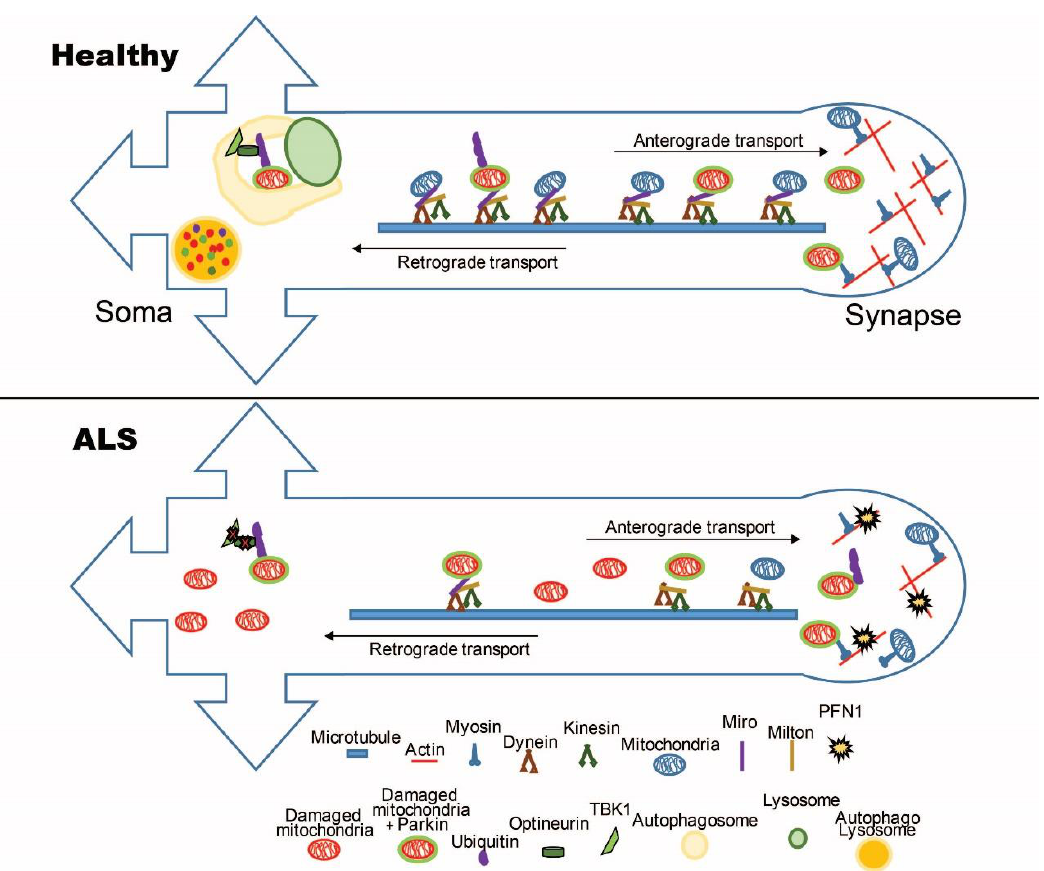
Figure 1. Schematic representation of key players in mitochondrial transport and turnover in healthy and amyotrophic lateral sclerosis (ALS) neurons. Mitochondria are transported in axons along microtubule tracks by dynein and kinesins, which are connected to mitochondria through cargo adaptors Milton and Miro. In ALS axons, the interactions between mitochondria and microtubules are disrupted, resulting in impaired transport. At synapses, mitochondria interact with the actin cytoskeleton, and mutations in proteins involved in actin dynamics, such as PFN1, can alter mitochondrial localization at this neuronal site. Ubiquitination of unhealthy mitochondria by Ub-ligases, such as Parkin, target mitochondria for degradation through the autophagy pathway. TBK1 and optineurin promote PINK1-Parkin ubiquitination of mitochondrial dynamics proteins, such as Miro. In ALS neurons, the quality control mechanisms are affected by dysfunction occurring at various steps of the mitophagy process.